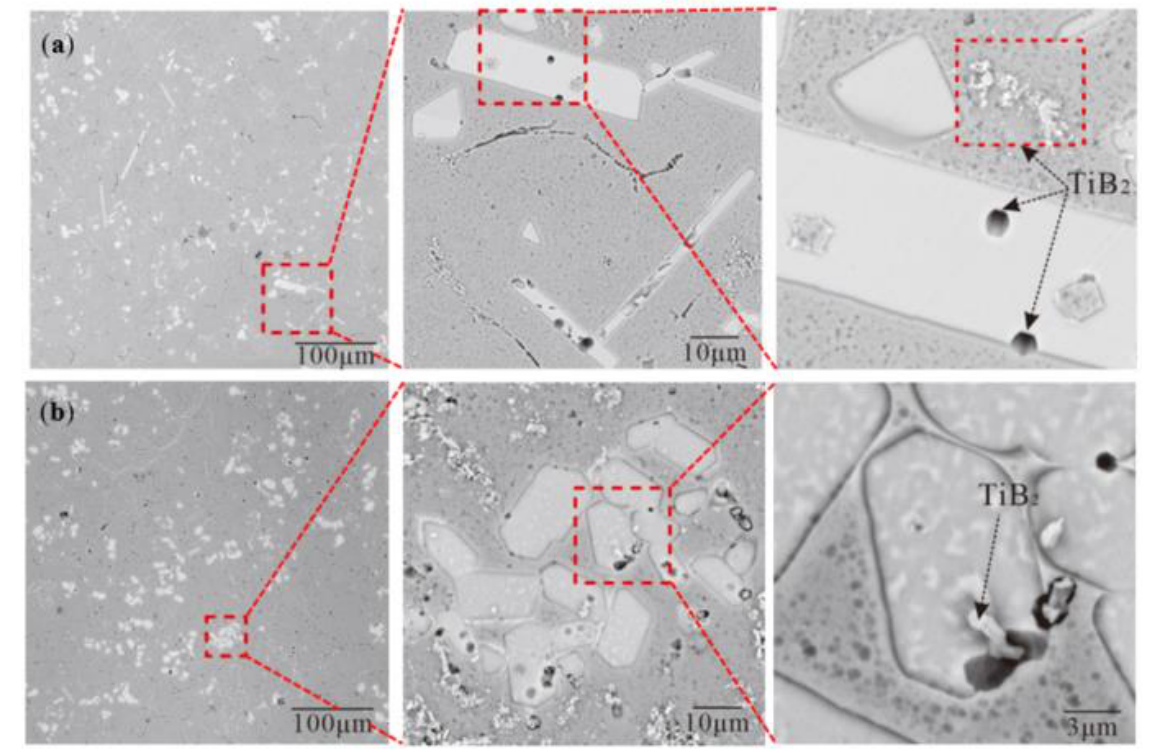
Figure 7. Microstructure of Al – Ti – B Master Alloy prepared by partial Ti-sponge route at 800 for 300 S: ( a ) 30% Ti-sponge route; ( b ) 60% Ti-sponge route.